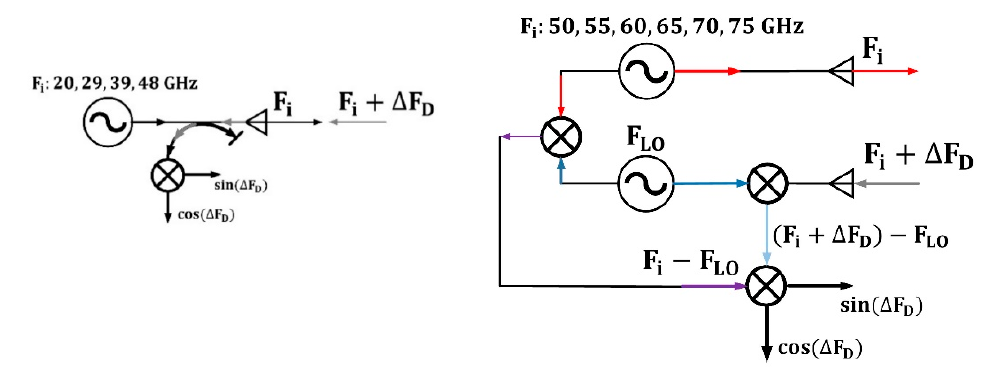
Figure 3. Schematics of DBS systems in Globus-M2. Table 2. Parameters of the performed modelling for circular filaments.